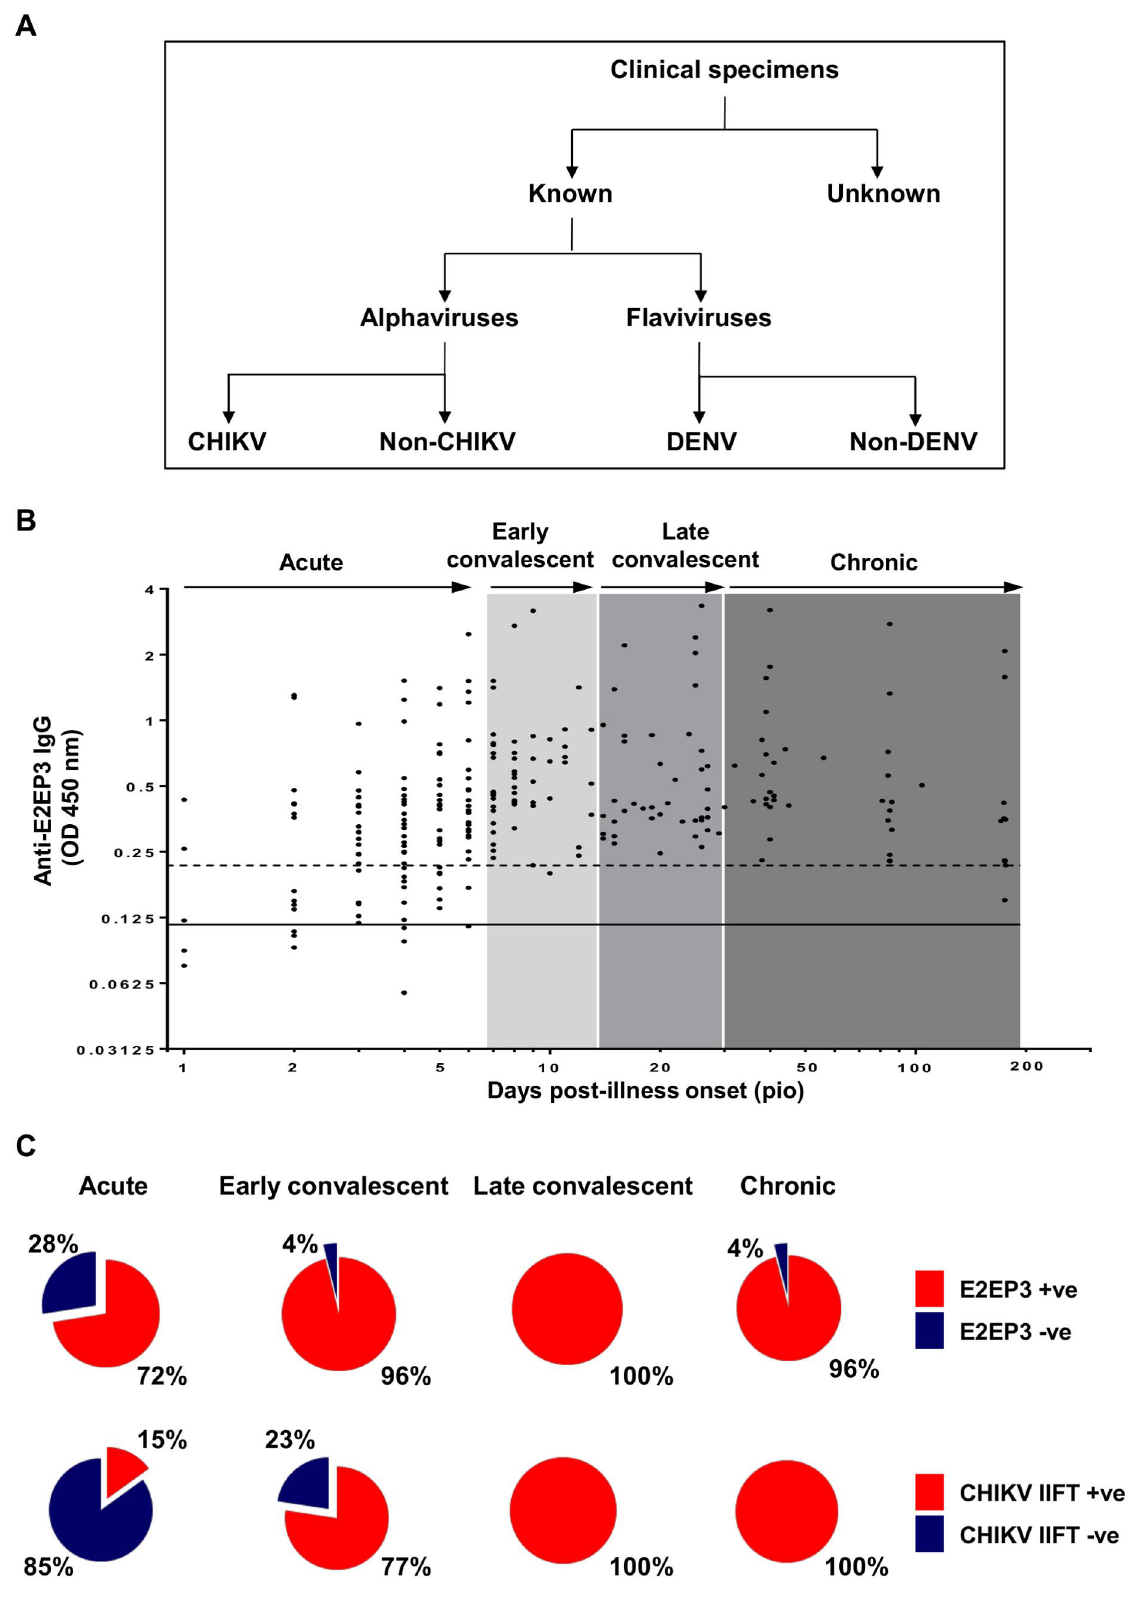
Fig. 1. Antibody profiles of CHIKV-infected patients. A, Schematic diagram on the classification of clinical specimens. Four hundred and ten clinical specimens were included in this study, 339 samples have validated by in-house screening methods including 60 flaviviruses-positive samples and 279 alphaviruses-positive samples. Validated samples were further sub-categorized into 4 groups: CHIKV; Non-CHIKV (positive for alphavirus);